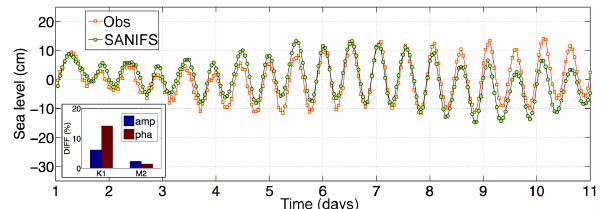
Figure 13. (a) Hourly time series of observed (red rows) and mod- elled (black rows) sea velocity direction. (b) Hourly time series of observed (yellow circles) and modelled (green squares) sea velocity intensity (bottom panel); time series of observed (red circles) wind intensity at station P1 and 10m wind speed of COSMOME (black squares) (top